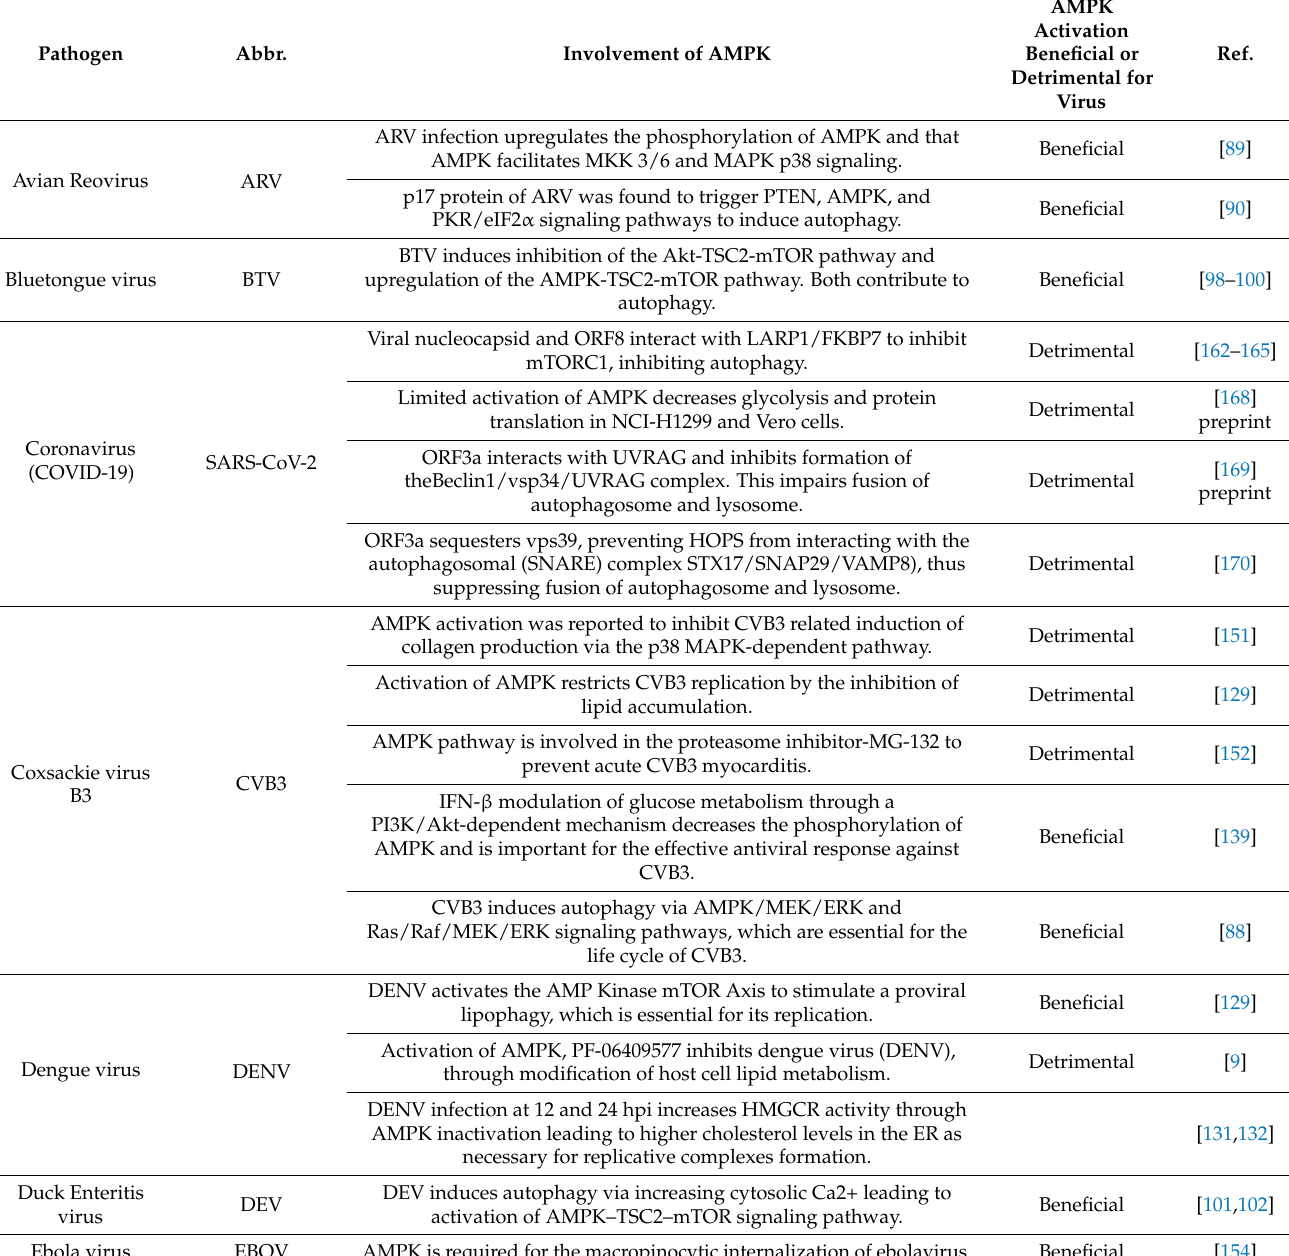
Table 1. Summary of pathogens and their respective involvement in regulating of AMPK activation, which serves as either beneficial or detrimental to viral replication, growth, and or evasion of host immune responses. (-) indicates undetermined conclusion. Pathogen Abbr. Involvement of AMPK